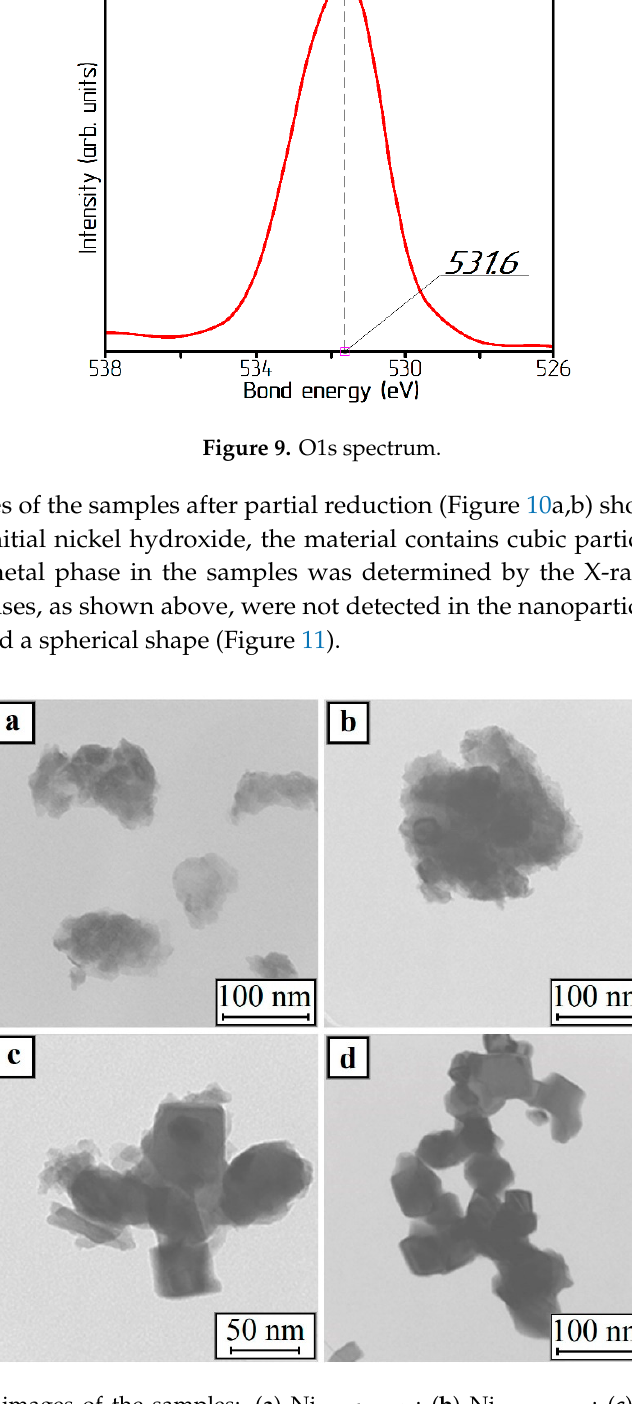
20;9;d;200;45 ; ( b ) Ni 20;9;c;200;90 ; ( c ) Ni 20;9;d;220;30 ; and